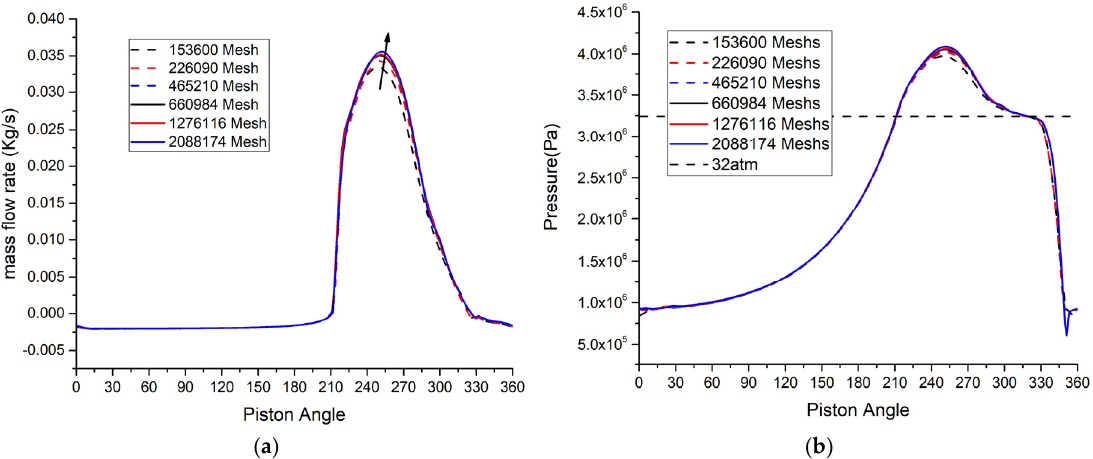
Figure 4. Grid independence test ( a ) discharge mass flow rate (at Outlet 3) at each rotation angle of piston with different number of meshes, ( b ) pressure of compression chamber at Inner 2 with different number of meshes.